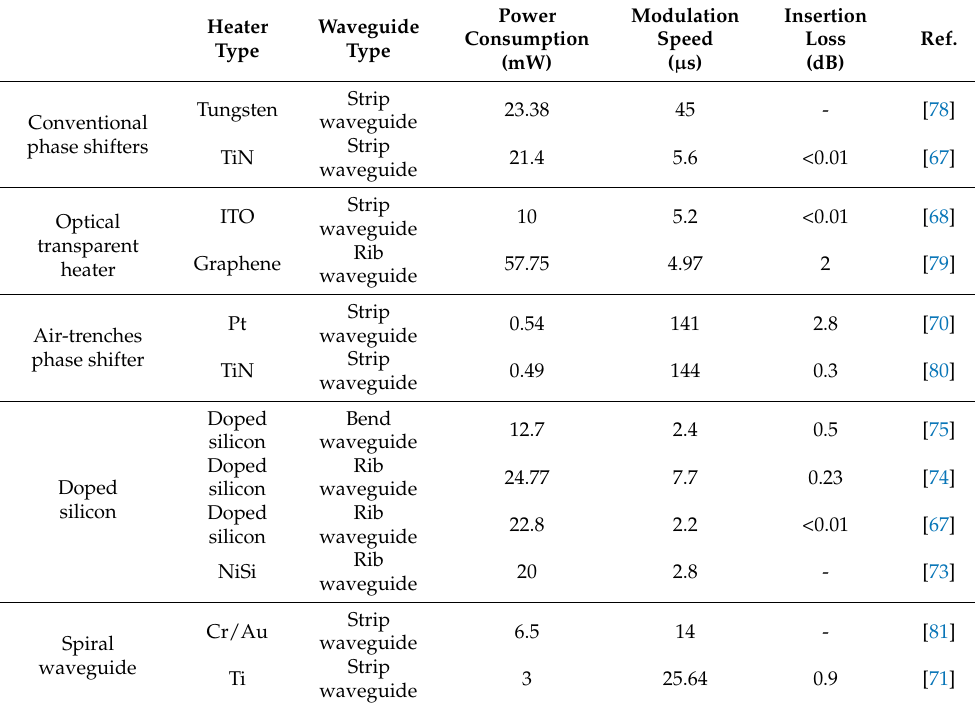
Table 2. Performance comparison of silicon photonic thermo-optics phase